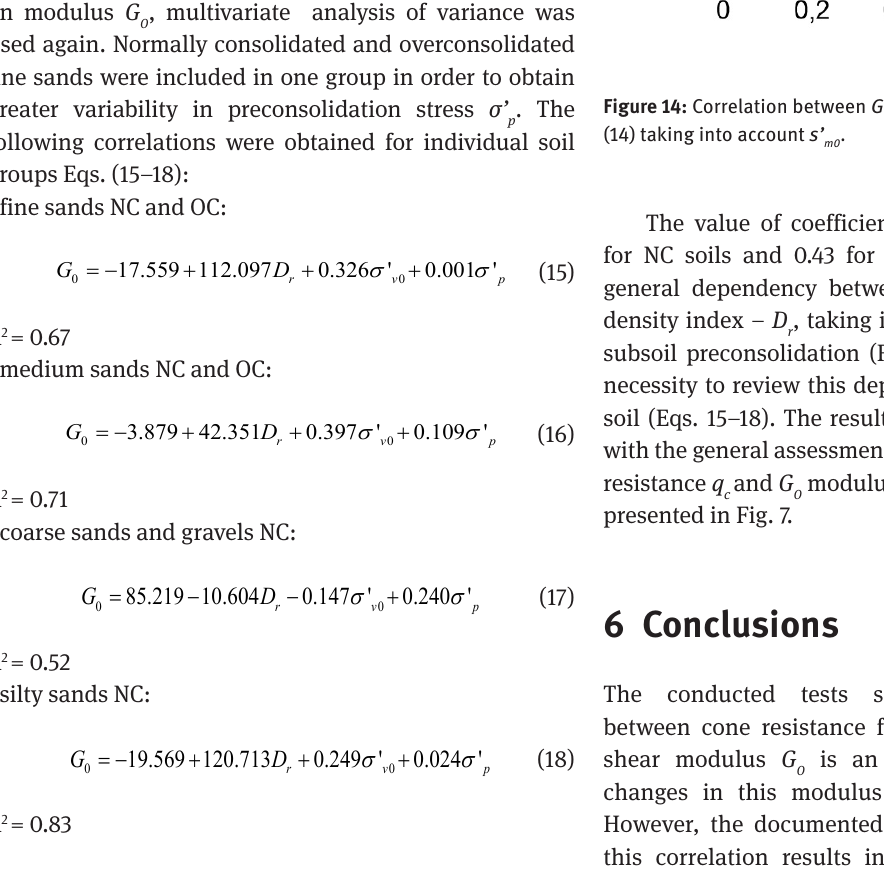
Figure 14: Correlation between G (14) taking into account s’